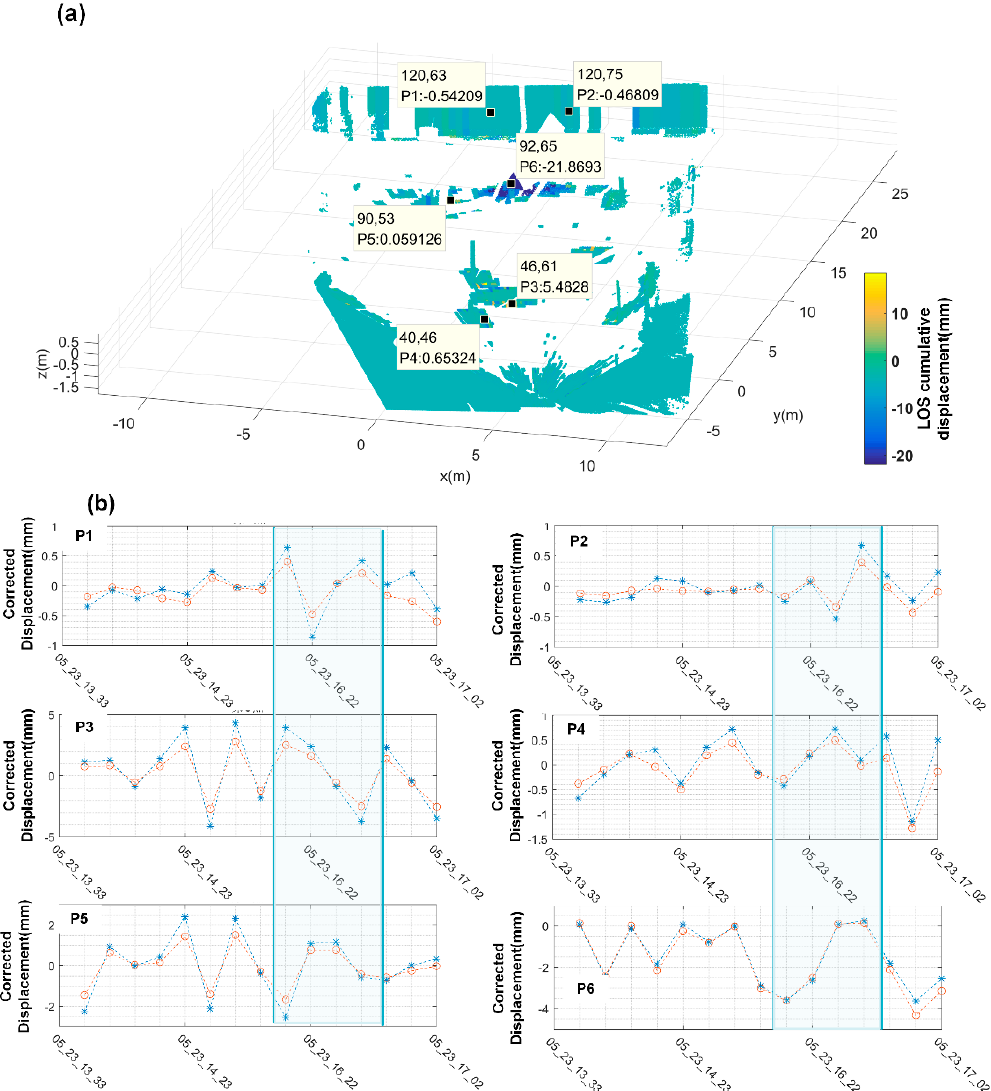
Figure 21. ( a ) Additional selected relative unstable points other than stable points, according to DA < 0.25 and evaded artifact effect; ( b ) The data of each point in the blue box showed some improvement, closer to zero. However, due to the system frequency instability, it was +/ − 0.34 mm, atmospheric correction had limited effect in this experiment.